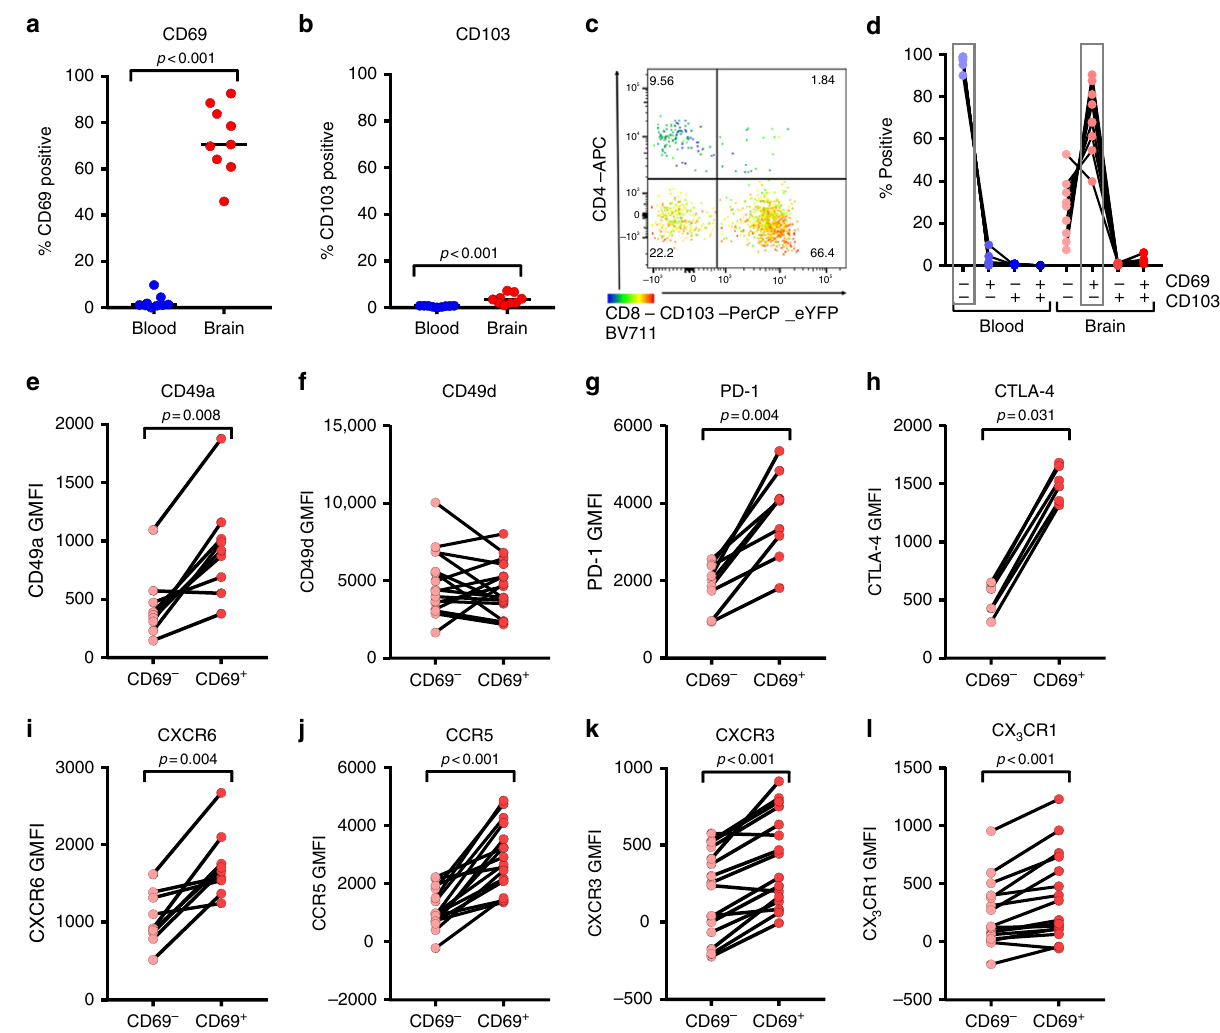
Fig. 8 Human brain CD4 + CD69 + T cells are enriched for core phenotypic T RM -cell markers. a , b , d Quanti fi cation of CD69 and CD103 (co-)expression. p - values show Mann – Whitney U test. c Representative dot plot of CD4, CD8, and CD103 staining of brain CD3 + CD69 + T cells. d Co-expression of CD69 and CD103. The dominant phenotype was CD69 − CD103 − in blood and CD69 + CD103 − in brain. e – l Quanti fi cation of CD4 + T-cell expression levels of CD49a, CD49d, PD-1, CTLA-4, CXCR6, CCR5, CXCR3, and CX 3 CR1 (GMFI, geometric mean fl uorescence intensity). p -values show the Wilcoxon